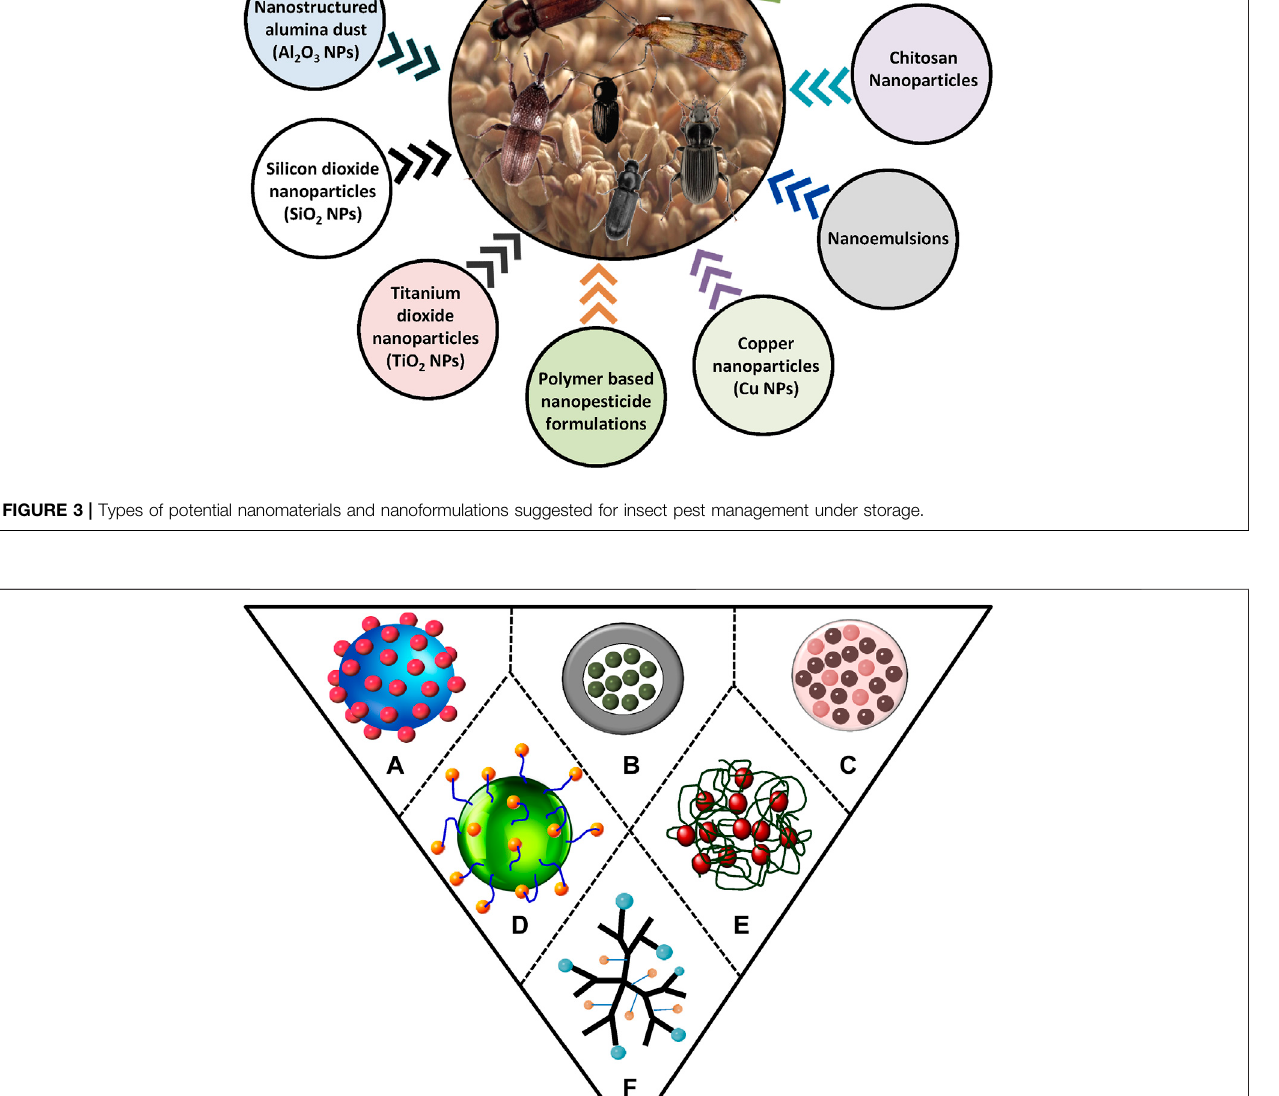
Frontiers in Nanotechnology |